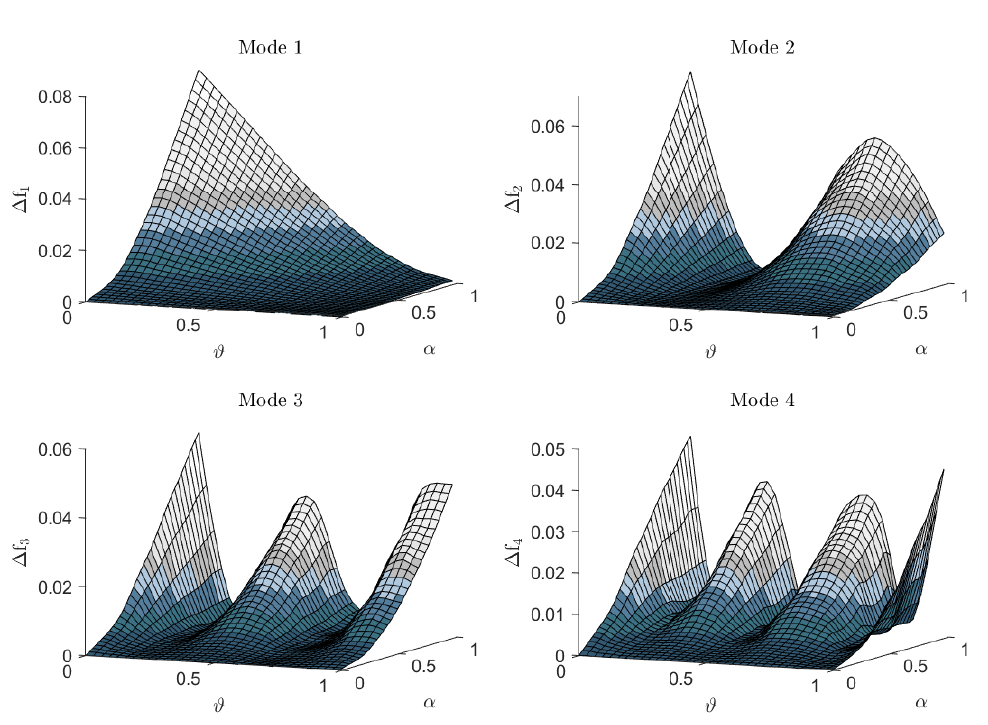
Figure 3. Relative changes of eigenfrequencies ∆ f for the [1st–4th] modes, calculated for different values of damage severity α , and normalized damage location ϑ